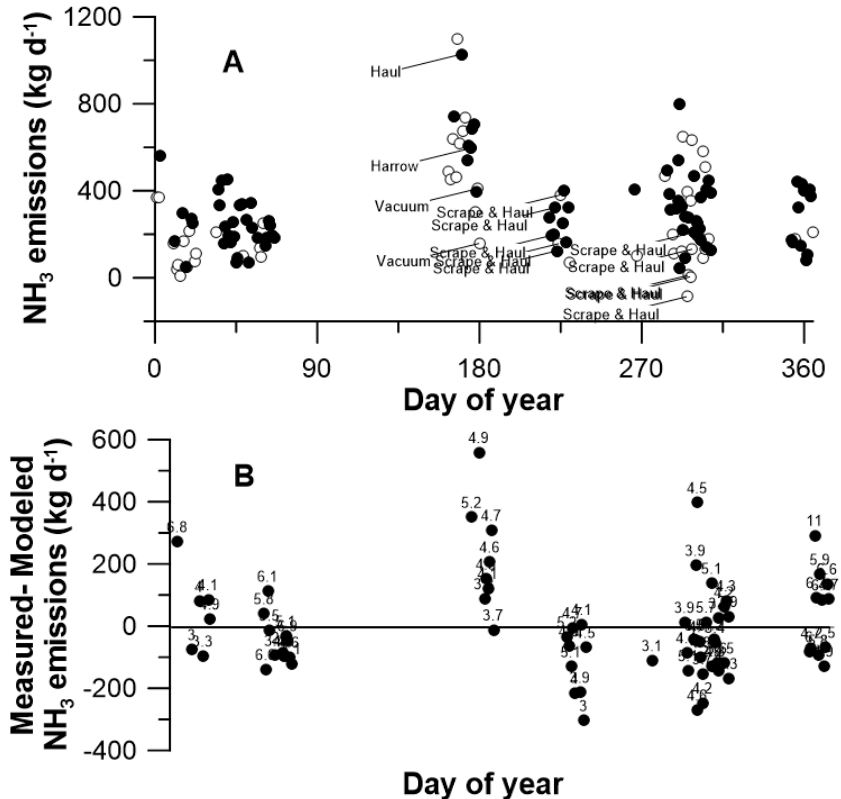
Figure 8. Daily NH 3 emissions. Representative daily mean emissions based on a touchdown fraction (TD) threshold of 0.4 and minimum of 24 half-hourly measurements per day (solid circles) as well as emission with fewer measurements per day (open circles) are indicated in Panel ( A ). Datum labels in panel A indicate specific major activity on the farm from Table 1. Daily emissions model error for representative days ( ≥ 24 measurements / day, TD > 0.4) are indicated in Panel ( B ) with datum labels indicating the associated mean daily wind speed.